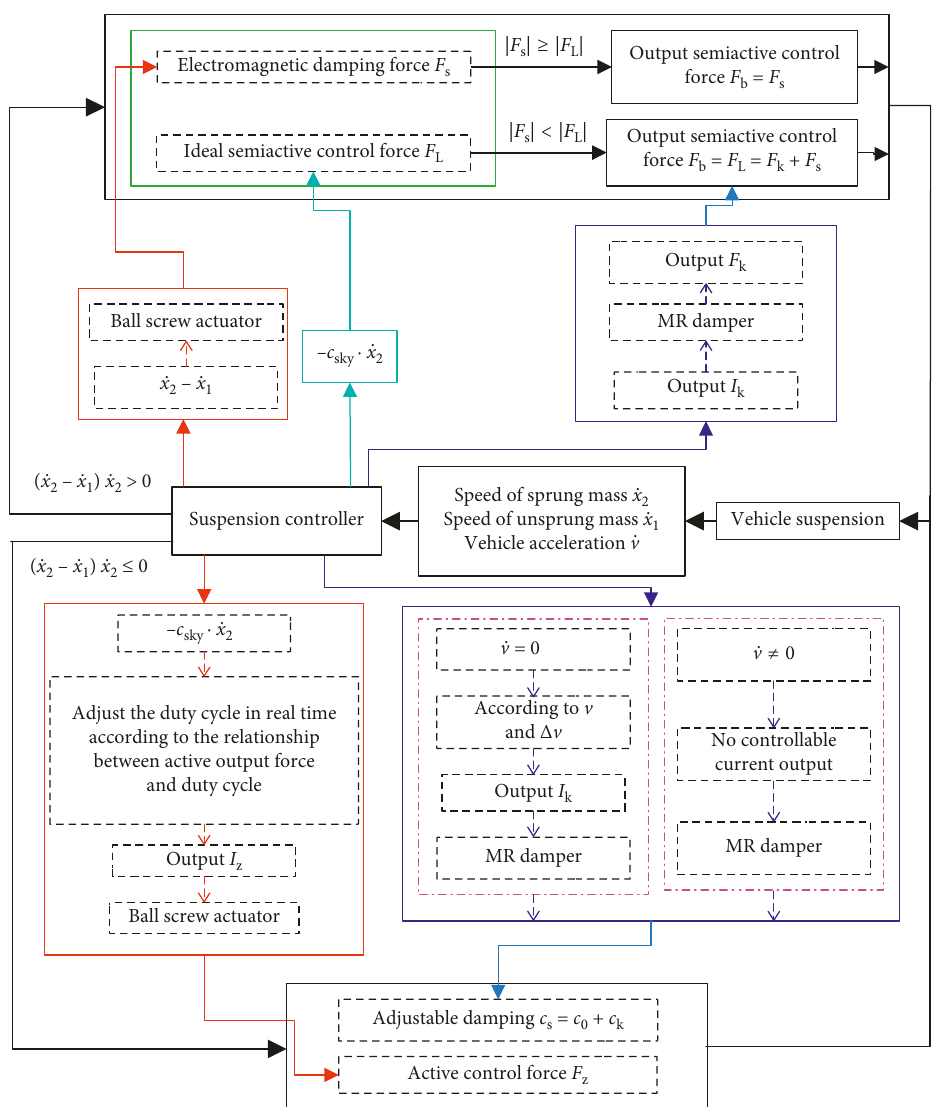
Figure 18: The frame diagram of the multimode coordinated control strategy of the hybrid suspension.